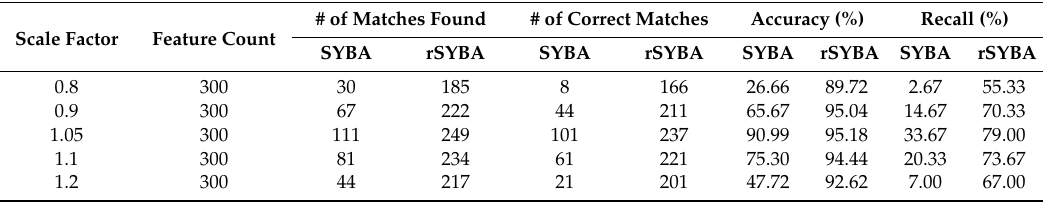
Table 1. Accuracy comparison for Scale Image Sequence.